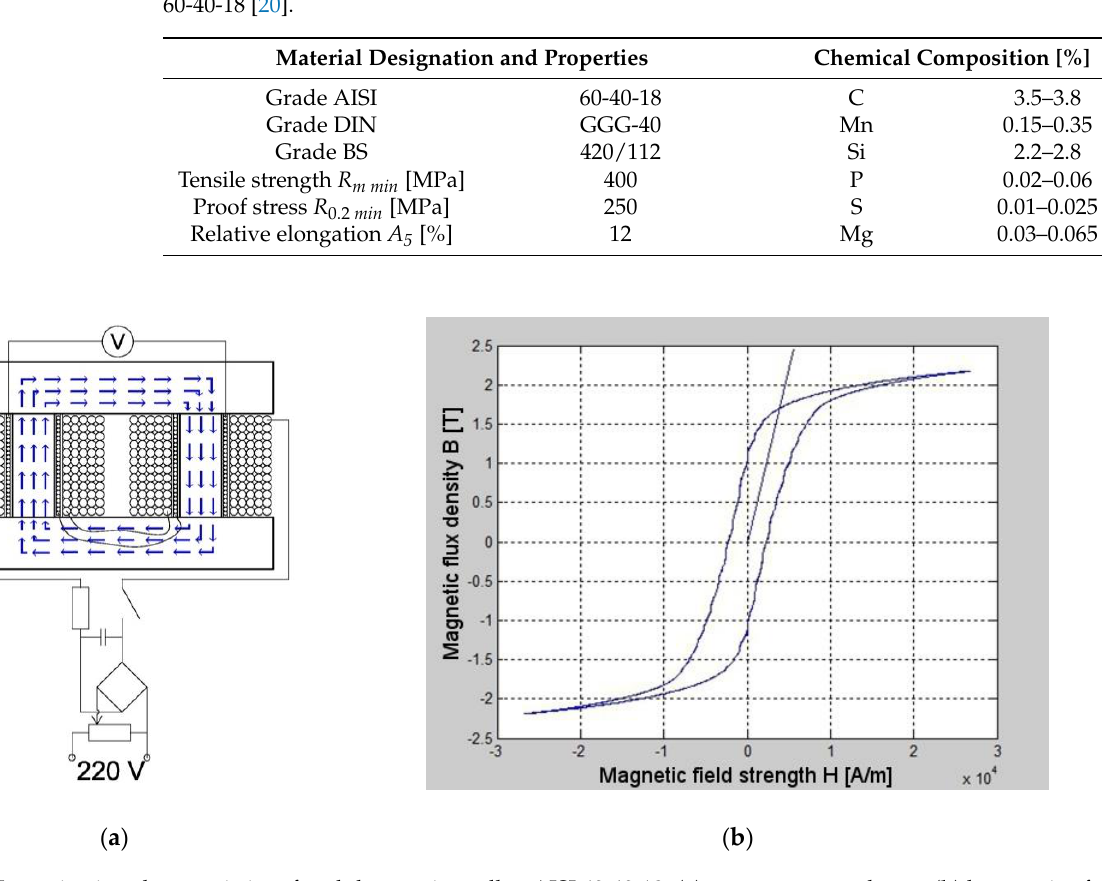
Figure 2. Magnetization characteristics of nodular cast iron alloy AISI 60-40-18: ( a ) measurement scheme; ( b ) hysteresis of casting iron magnetization.